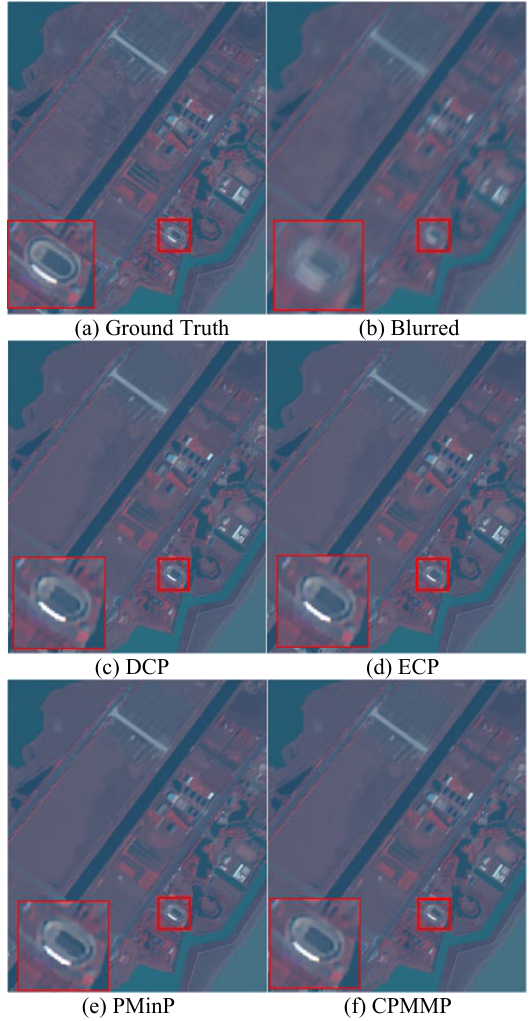
Figure 6. Deblurring results for simulated images with the second blur kernel in Levin et al. (2009). Zoom the suset in red